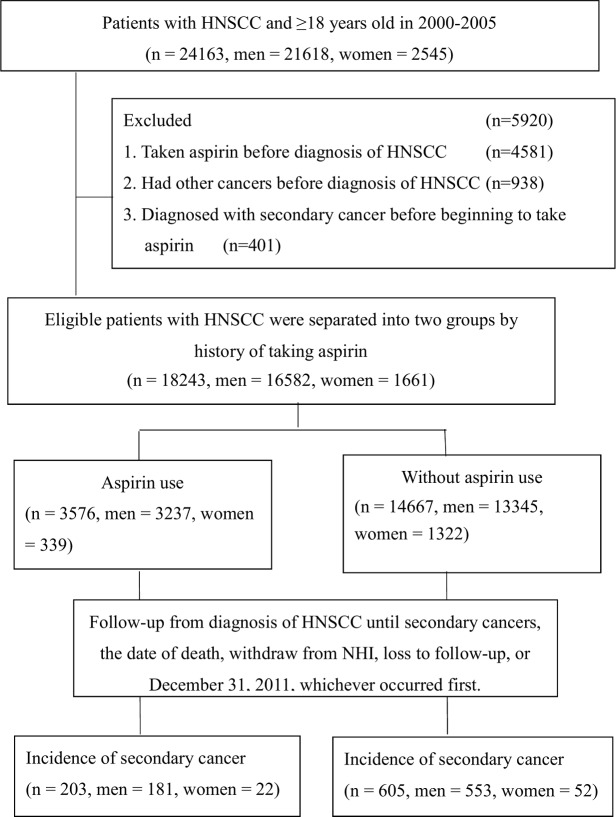
Study population selection.Patients with squamous cell carcinoma of head and neck cancer (HNSCC) were selected from the Registry for Catastrophic Illness Patient (RCIP) database in the National Health Insurance Research Database (NHIRD) in Taiwan.